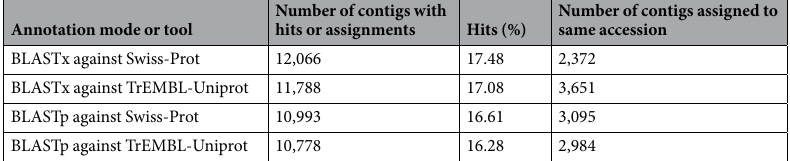
Table 4. Annotation summary for YO/IDR/ESA transcriptome.